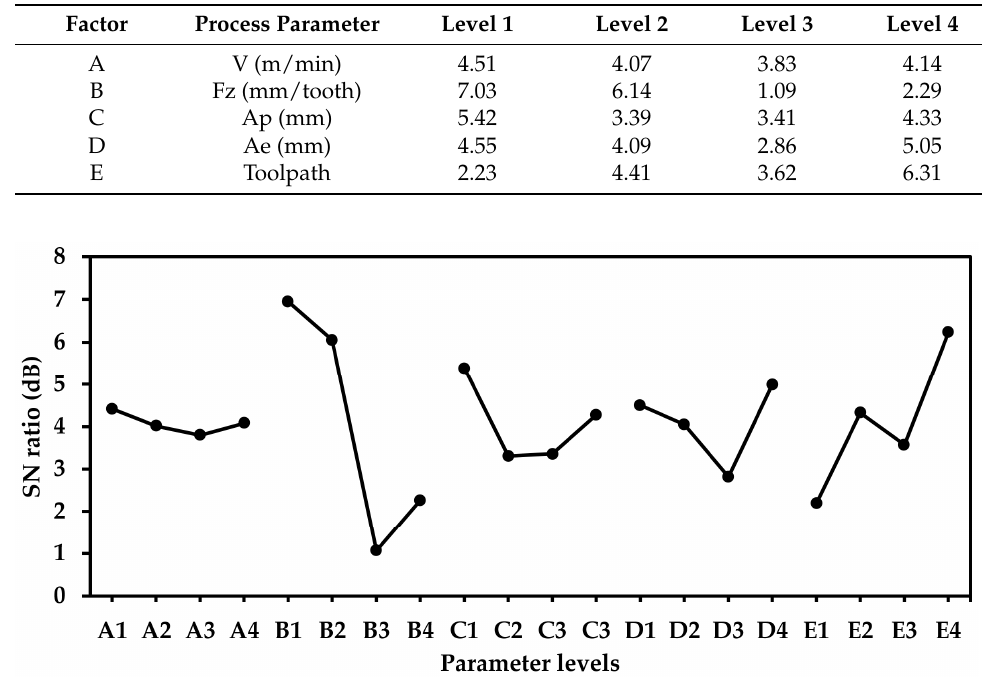
Figure 10. The deformation factor response diagram. Table 6. Analysis of deformation variance.